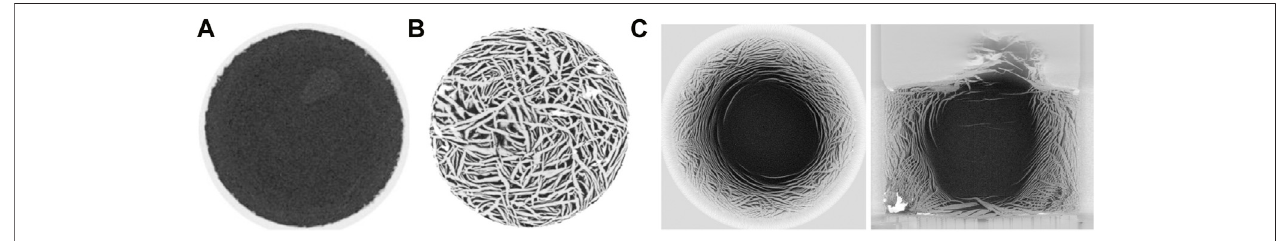
FIGURE 12 | Frozen soil. (A) Pore invasive ice formation in sand (no lenses). Grain-displacive ice lenses in (B) bentonite paste and in (C) kaolinite paste (Viggiani et al., 2015).